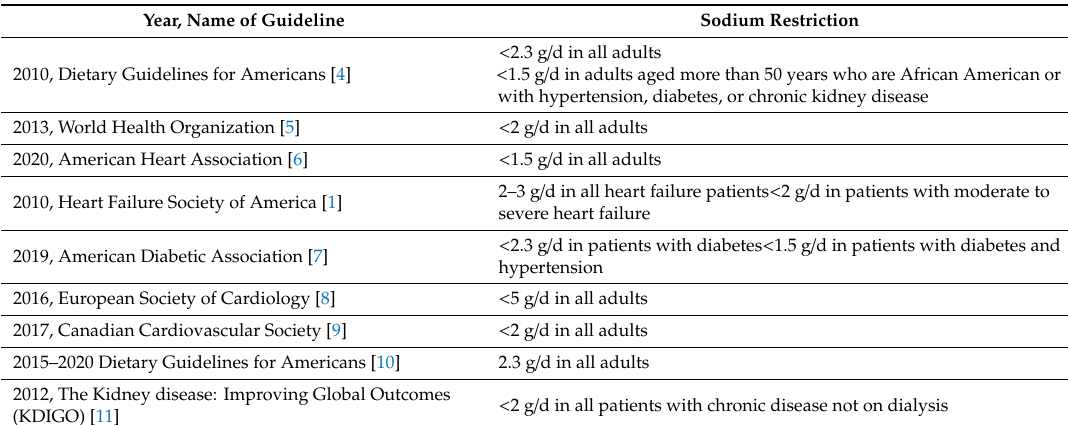
Table 1. Guideline recommendations for sodium restriction in the general